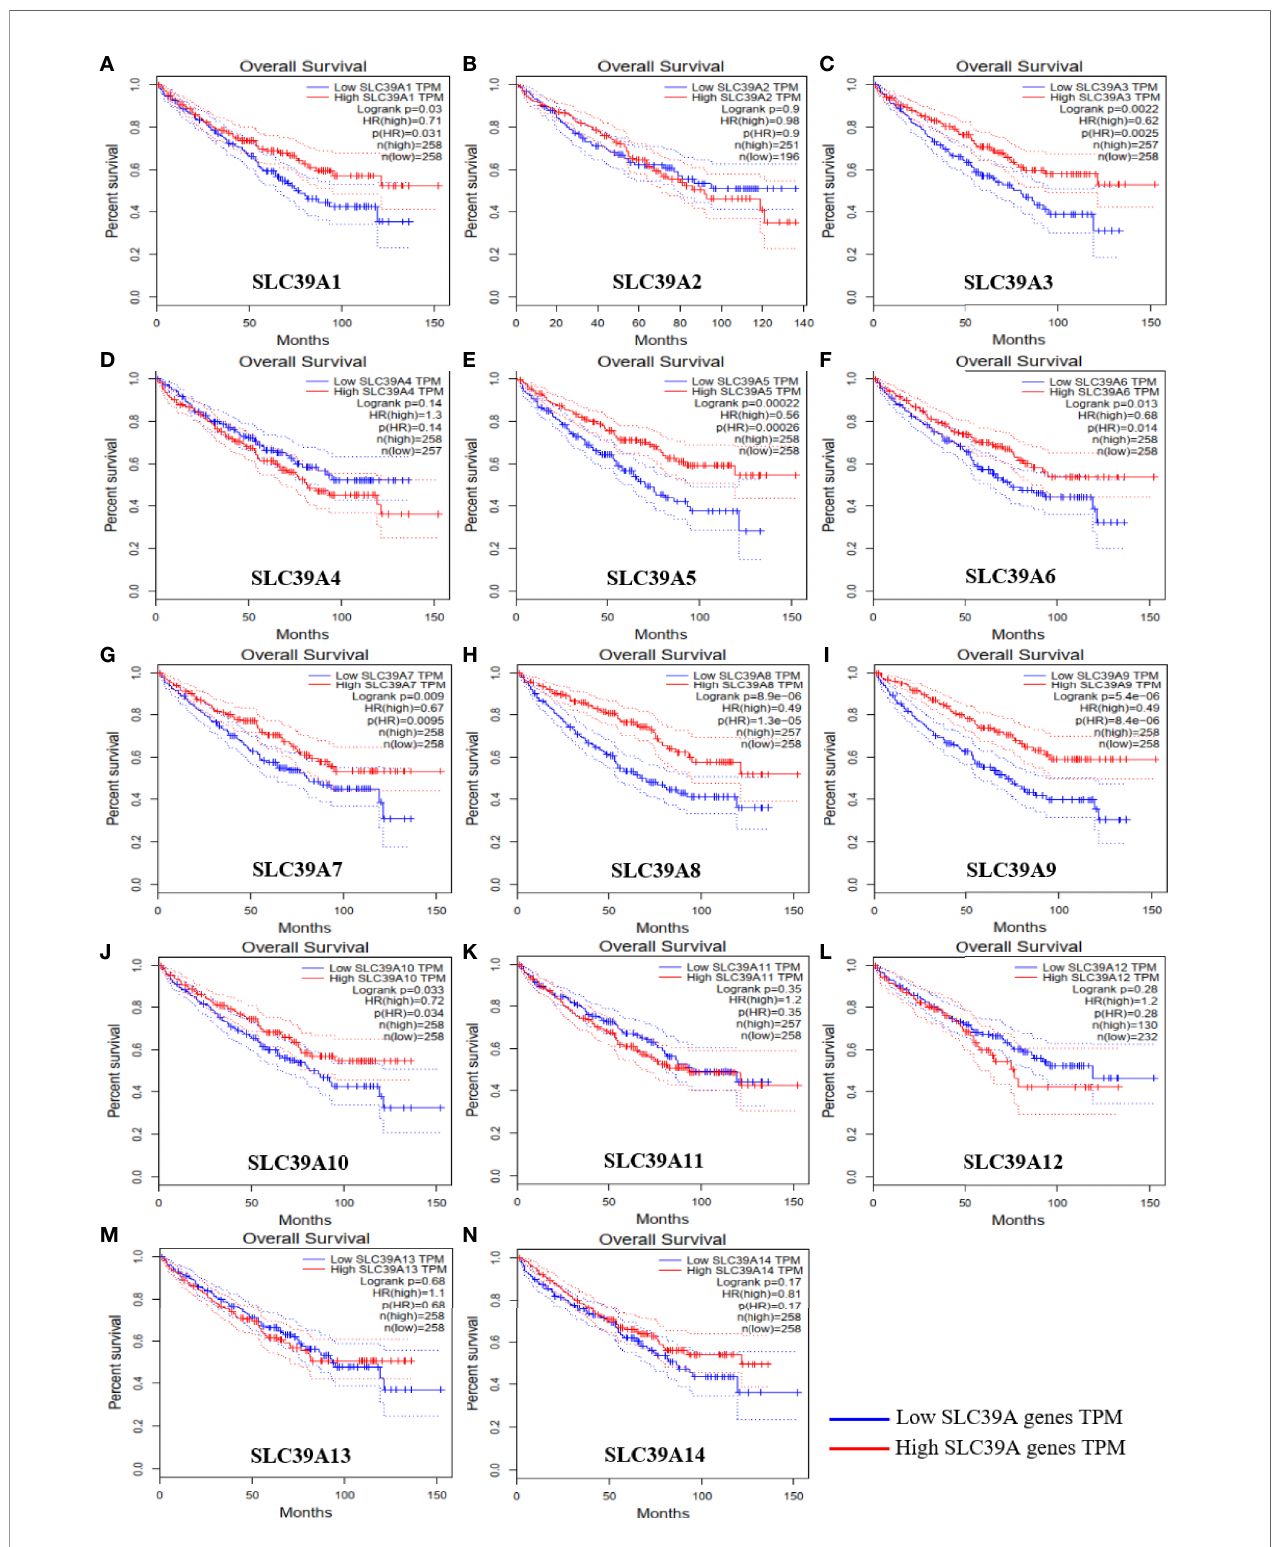
FIGURE 2 | Overall survival of ZIP family genes in patients with ccRCC by using GEPIA. (A – N) SLC39A1, SLC39A2, SLC39A3, SLC39A4, SLC39A5, SLC39A6, SLC39A7, SLC39A8, SLC39A9, SLC39A10, SLC39A11, SLC39A12, SLC39A13, SLC39A14. Mean differences were considered statistically signi fi cant when P